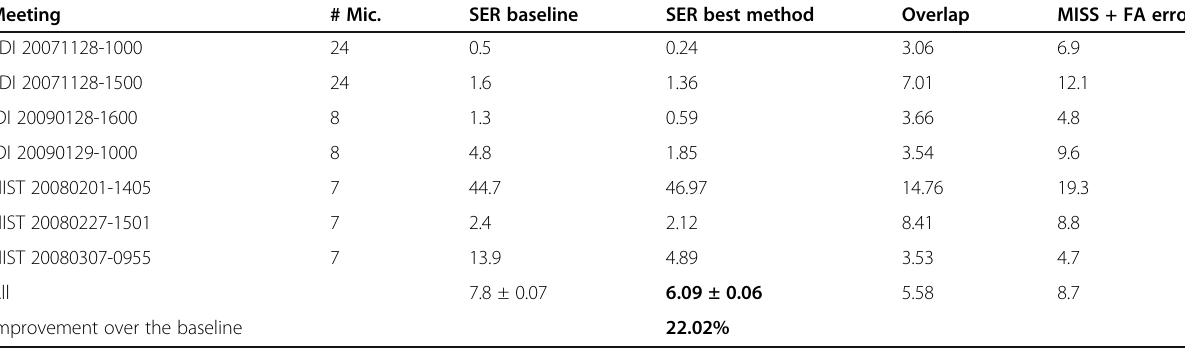
Table 9 Detailed results for the RT-09 set with the best system ((A-B) = (7-50) with K = 0.01) Meeting # Mic.